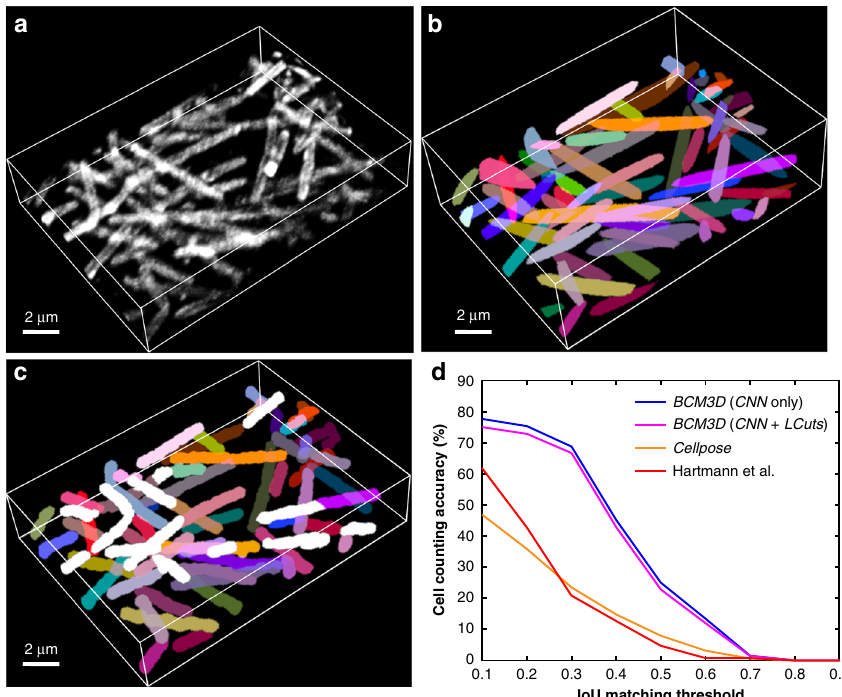
Fig. 5 3D Segmentation accuracy evaluation using M. xanthus bio fi lm images (cell density = 36.2%, and SBR = 1.58). a Maximum intensity projection of a 3D M. xanthus fl uorescence image. Cells were labeled with membrane-intercalating dye, FM4-64. Similar images were obtained at N = 120 different time points. b Maximum intensity projection of the manually obtained 3D segmentation result. c Maximum intensity projection of a CNN-based 3D segmentation result after LCuts post-processing. Cells that can be matched with the GT are displayed in the same colors as GT or otherwise colored in white. d Segmentation accuracy of compared algorithms parameterized in terms of cell counting accuracy ( y -axis) and IoU matching threshold ( x -axis). Source data are provided as a Source data fi le for Fig.